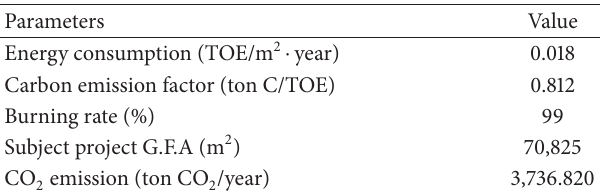
Table 5: Annual CO emissions for the residential building 2